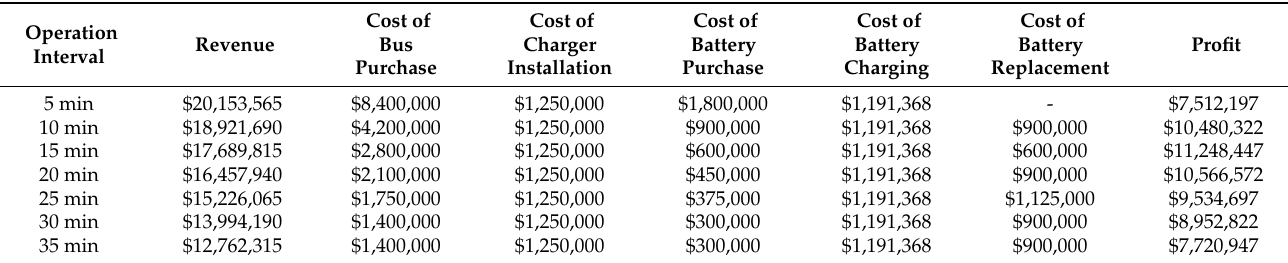
Table 5. The results according to the changes in the operation